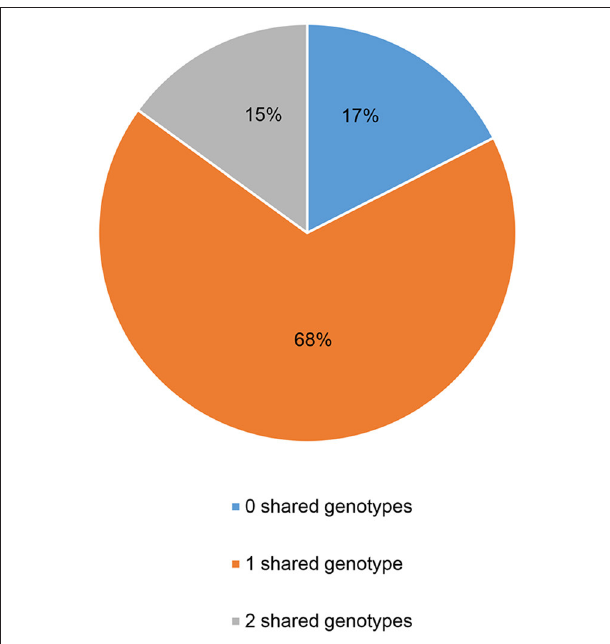
FIGURE 2 | Fidelity of transmission of S. sobrinus genotypes from mother to child.